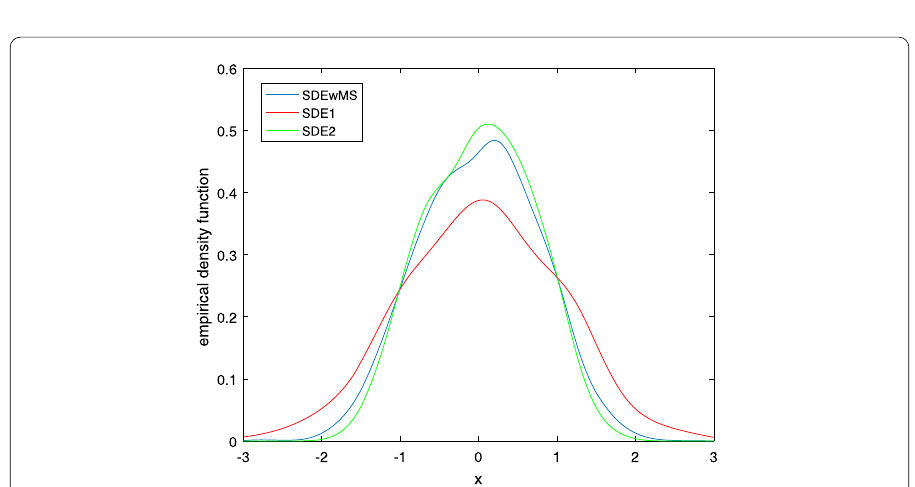
Figure 4 Empirical probability density functions when T = 10